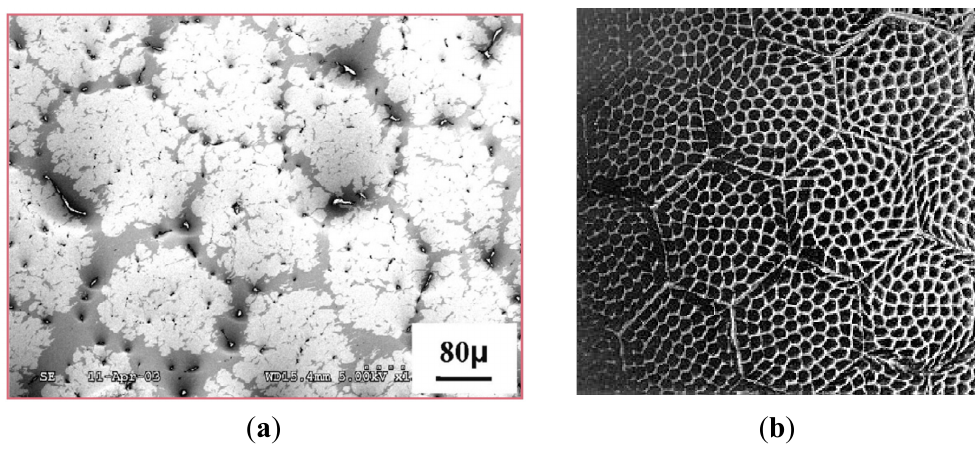
Figure 2. Cross-sections of polycrystalline diamond (PCD) cellular rods with thick cell boundaries (( a ) is reprinted with permission from [5]; ( b ) is adapted from